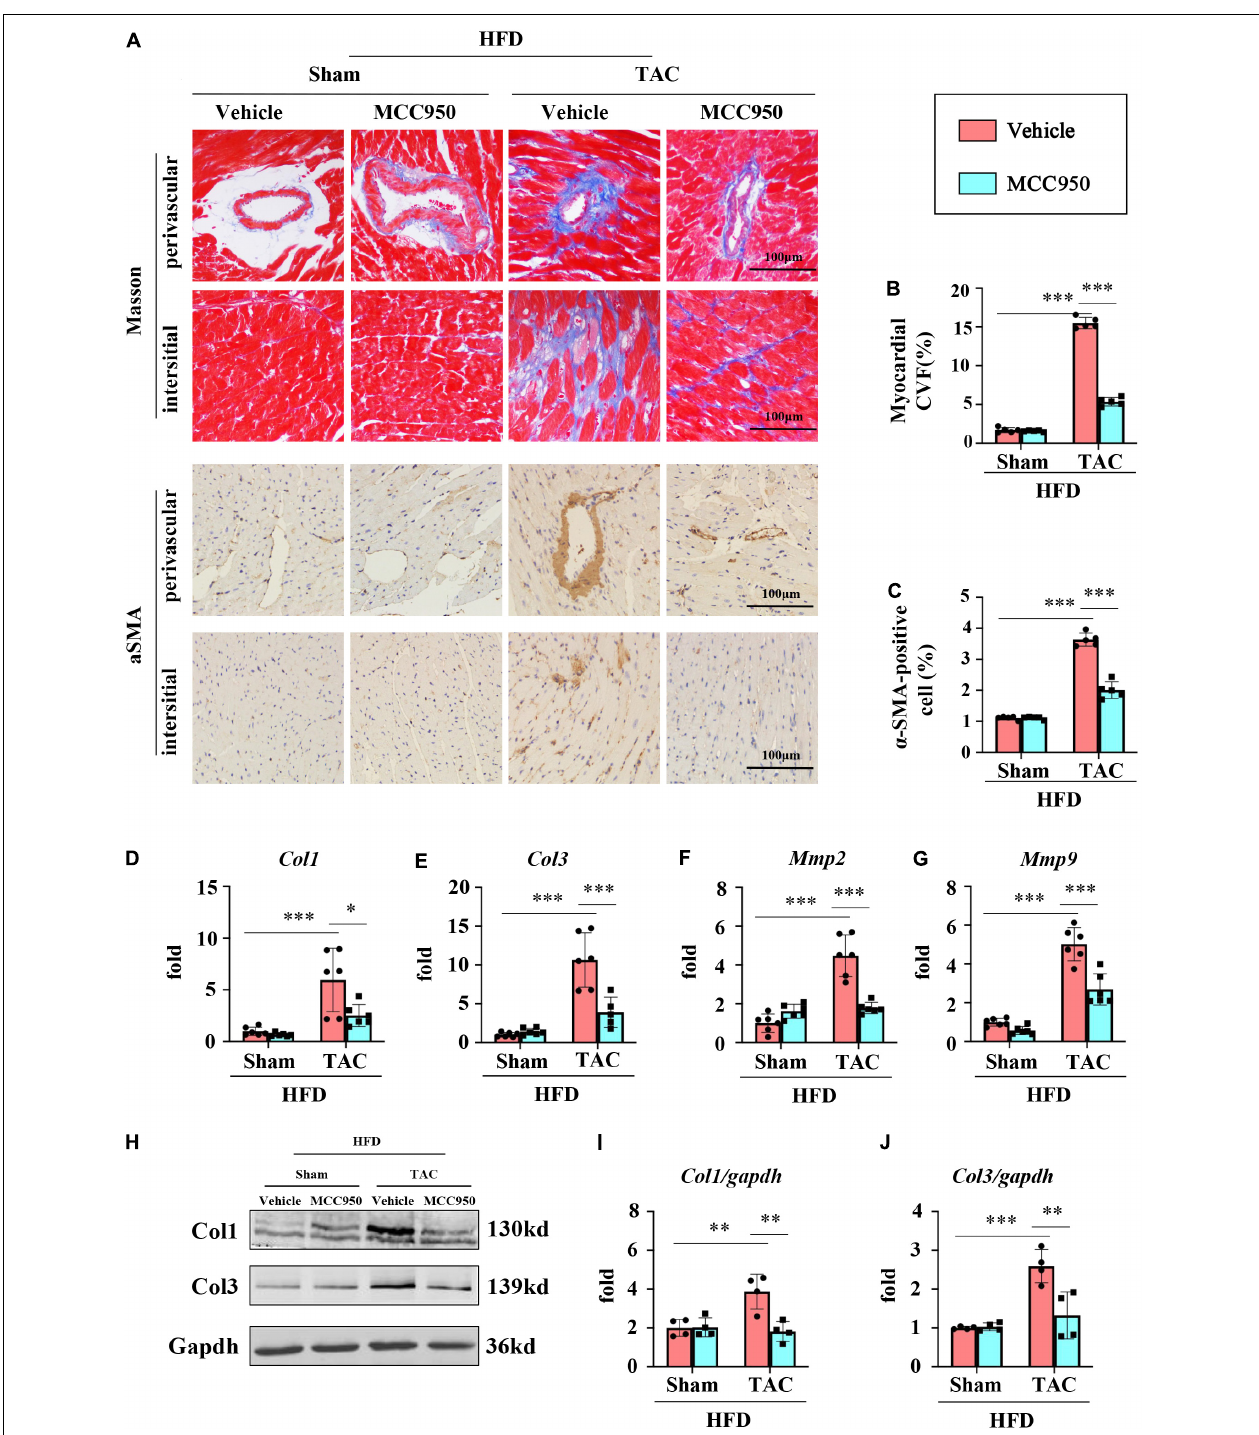
FIGURE 3 | MCC950 ameliorates pressure overload-induced cardiac fibrosis. (A) Representative images of Masson’s trichrome and α SMA immunohistochemistry staining, n = 5. (B) Statistical results for the fibrotic areas in the indicated groups, n = 5. (C) Statistical results for the α SMA positive cells in the indicated groups, n = 5. (D) Relative mRNA expression of COL1, (E) COL3, (F) MMP-2, (G) MMP-9, n = 6. (H–J) Representative Western blot and quantitative analysis showing the expression levels of COL1 and COL3. α SMA, α -smooth muscle actin; COL, collagen; MMP, matrix metalloproteinase. ∗ p < 0.05, ∗∗ p < 0.01, ∗∗∗ p < 0.001.